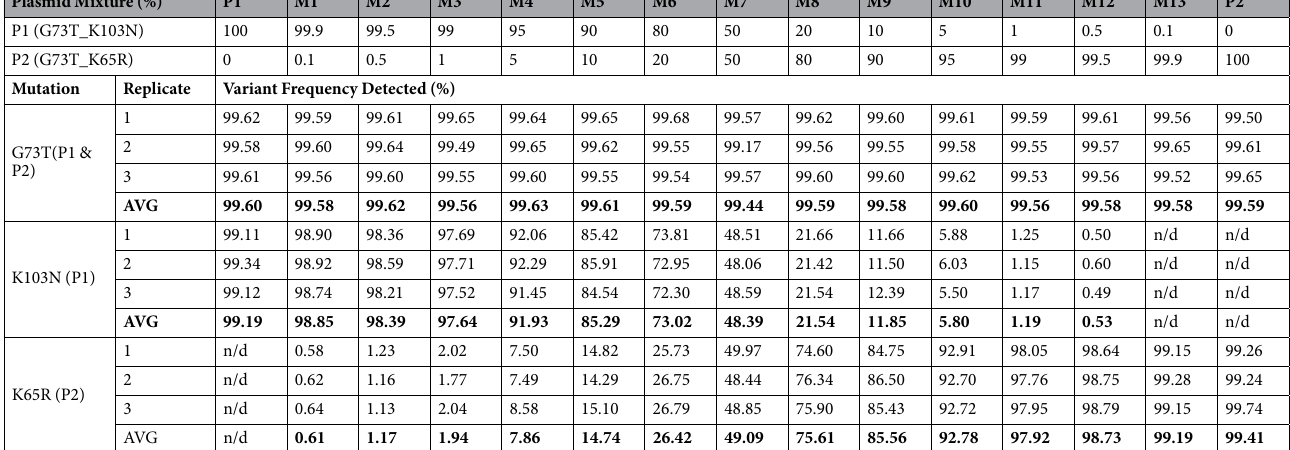
Table 2. Sensitivity for the detection of minor variants in mixed plasmid populations by the MiSeq-HyDRA platform. * n/d = not